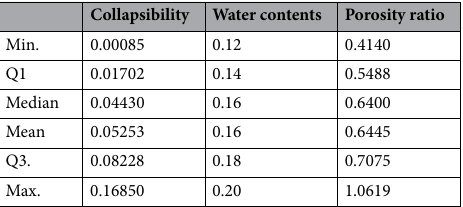
Table 4. Summary of coefficient of collapsibility and other basic physical properties for Loess samples; Yan’an. Min minimum, Q1 1st quantile, Q3 3rd quantile, Max maximum.